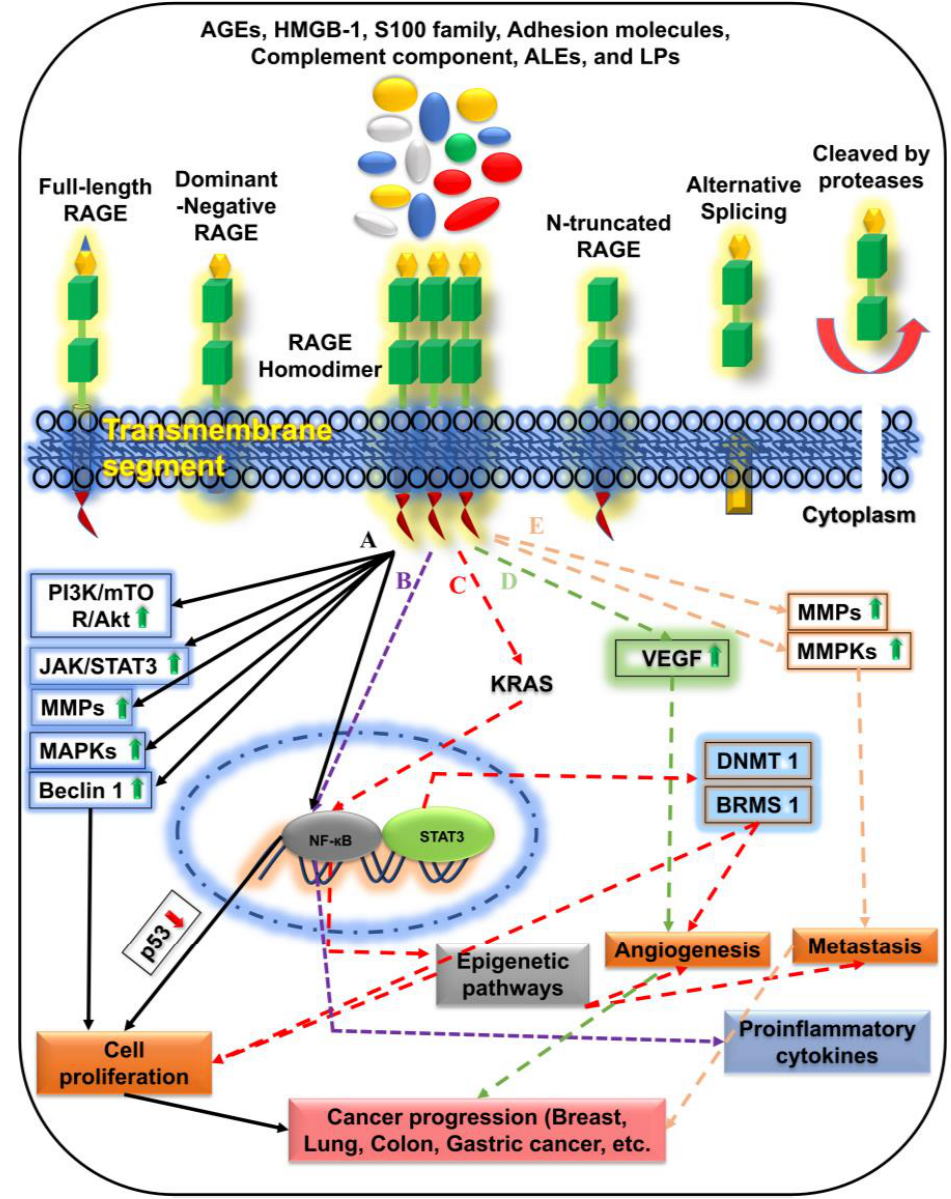
Figure 2. Schematic illustration of the functions of a receptor for advanced glycation end products (RAGE) in the cancer microenvironment: ( A ) binding of RAGE and its ligands promotes angiogenesis and cancer development by upregulating PKI3/mTOR/Akt, MAPKs, MMPs, VEGF, NF- κ B, and downregulating p53 signaling; ( B ) secretion of HMGB1 from inflamed or injured cells followed by its binding with RAGE results in the increased release of proinflammatory cytokines via NF- κ B activation and ensuing harmful inflammatory responses; ( C ) HMGB1 operates via NF- κ B and epigenetic pathways in the cancer microenvironment to exert its long-lasting effects on surviving tumor cells, immune cells, and stromal cells. Together with STAT3, NF- κ B controls genes that promote metastasis, angiogenesis, and cancer development; ( D ) upregulation of VEGF leads to angiogenesis resulting in cancer progression; and ( E ) increased expression of MMPs and MMPKs promotes metastasis in various cancers. Amphoterin (HMGB1) is an electrically neutral non-histone protein involved in tran- scription, DNA repair, differentiation, neural development, and extracellular signaling, and has a plausible connection with cancer. HMGB1 is a cytokine released by